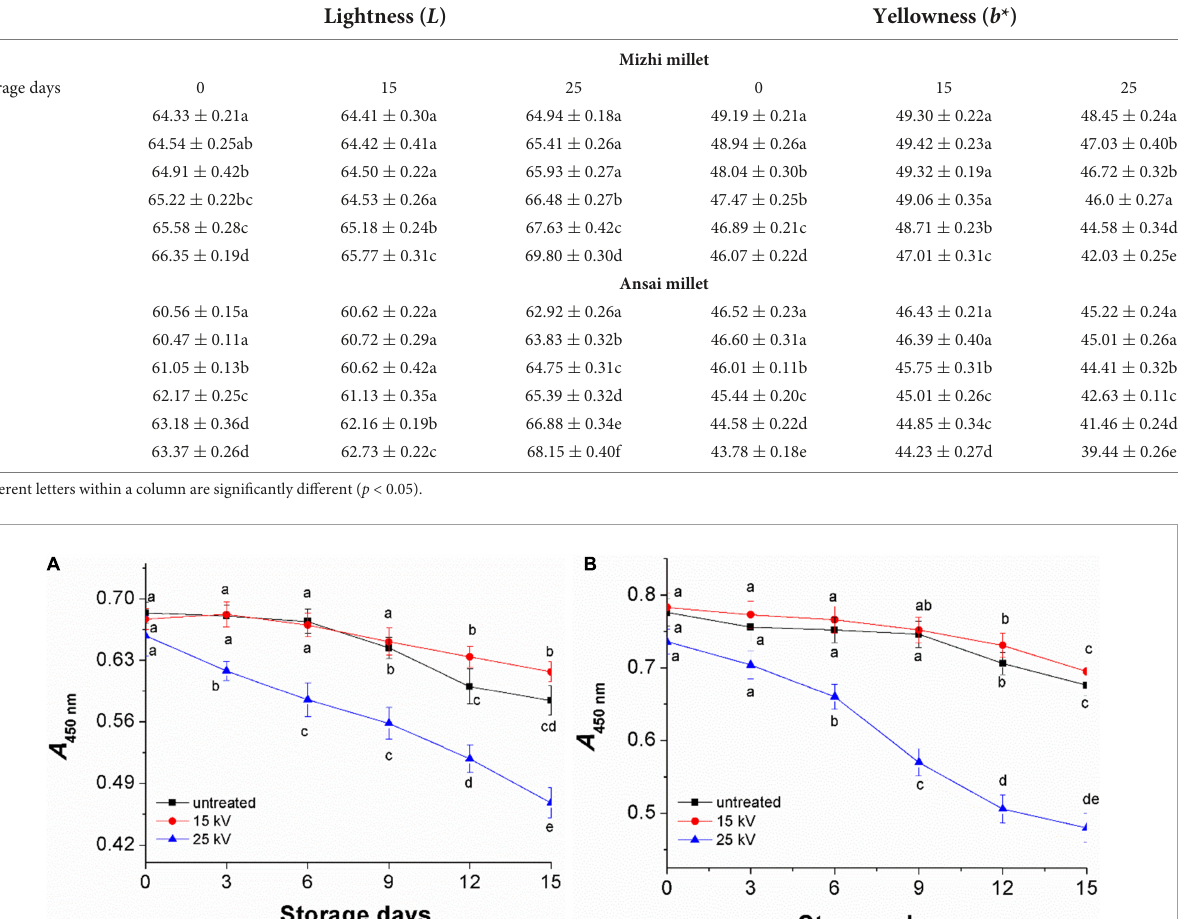
TABLE 2 Changes in color indexes of foxtail millets with different treatment.